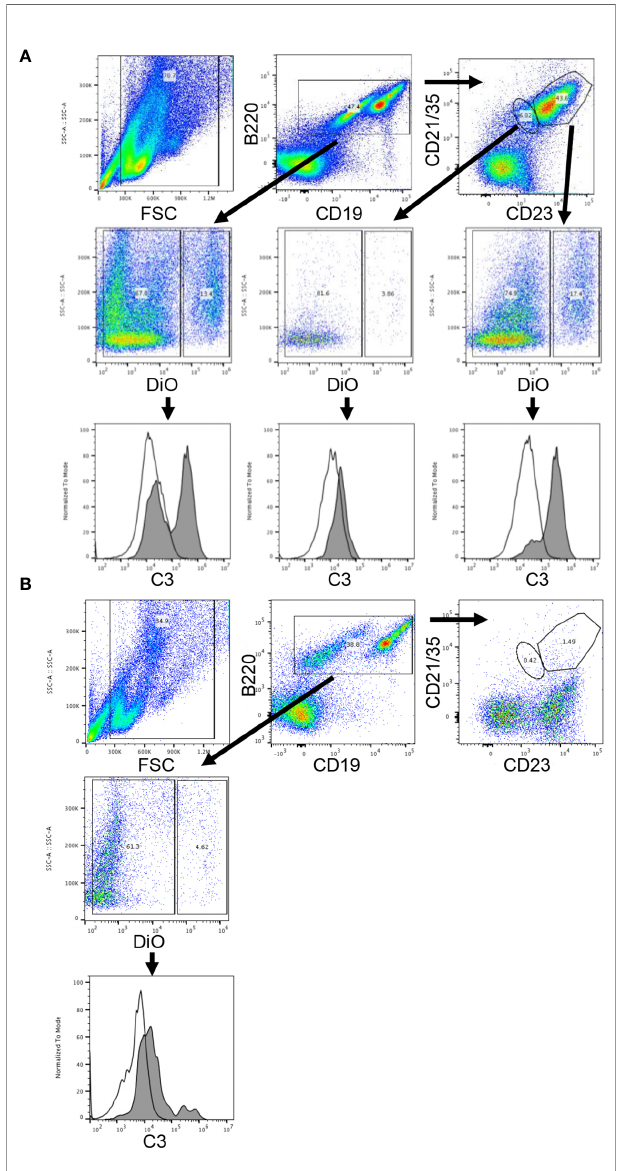
FIGURE 5 | Complement- fi xed KEL RBCs bind in-vitro to wild type donor derived B-cells but not to CR1/2 -/- B-cells. DiO labeled KEL RBCs were incubated with KELIg in the presence of sera, followed by incubation with peripheral blood derived WBCs from donor mice. (A) In wells using WBCs from wild type donor mice, CD19+B220+ B-cells cells were separated by DiO positivity and then by C3 positivity. The CD19+B220+ cells were next separated by their CD23 and CD21/35 expression, with the cells highest for CD23 and CD21/35 gated in the larger gate and those less strongly positive for CD23 and CD21/35 gated in the smaller gate; the DiO positive and negative populations were then evaluated for their C3 positivity. Shaded histograms are the DiO positive population, open histograms are the DiO negative population. (B) In wells using WBCs from CR1/2 -/- mice, CD19+B220+ B-cells cells were separated by DiO positivity and then by C3 positivity. Shaded histograms are the DiO positive population, open histograms are the DiO negative population. These data are representative of more than 3 independent experiments, with 2 involving CD23 and CD21/35